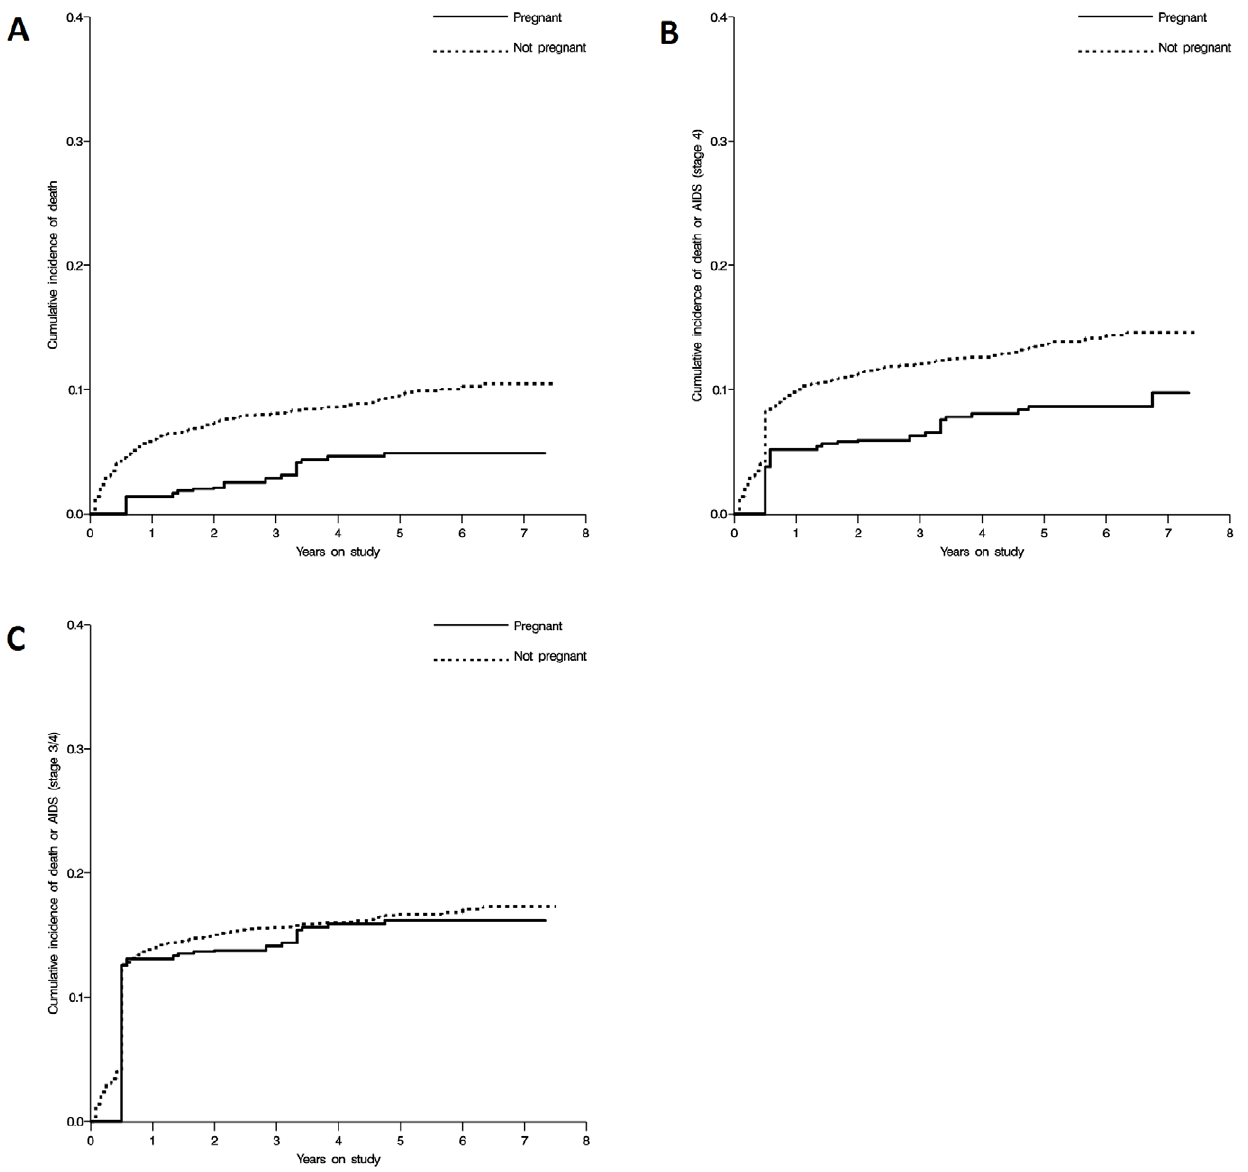
Figure 2. Effect of pregnancy on time to (A) death, (B) death or new stage 4 AIDS, or (C) death or new stage 3 or 4 AIDS. Curves are inverse, weighted, extended Kaplan-Meier